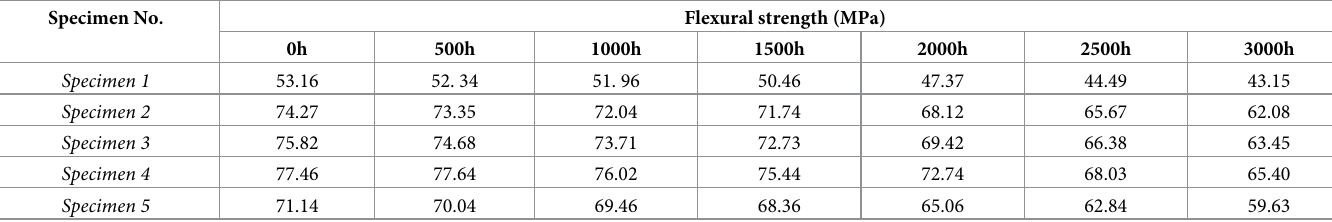
Table 4. Flexural strengths before and after UV-accelerated aging. Specimen